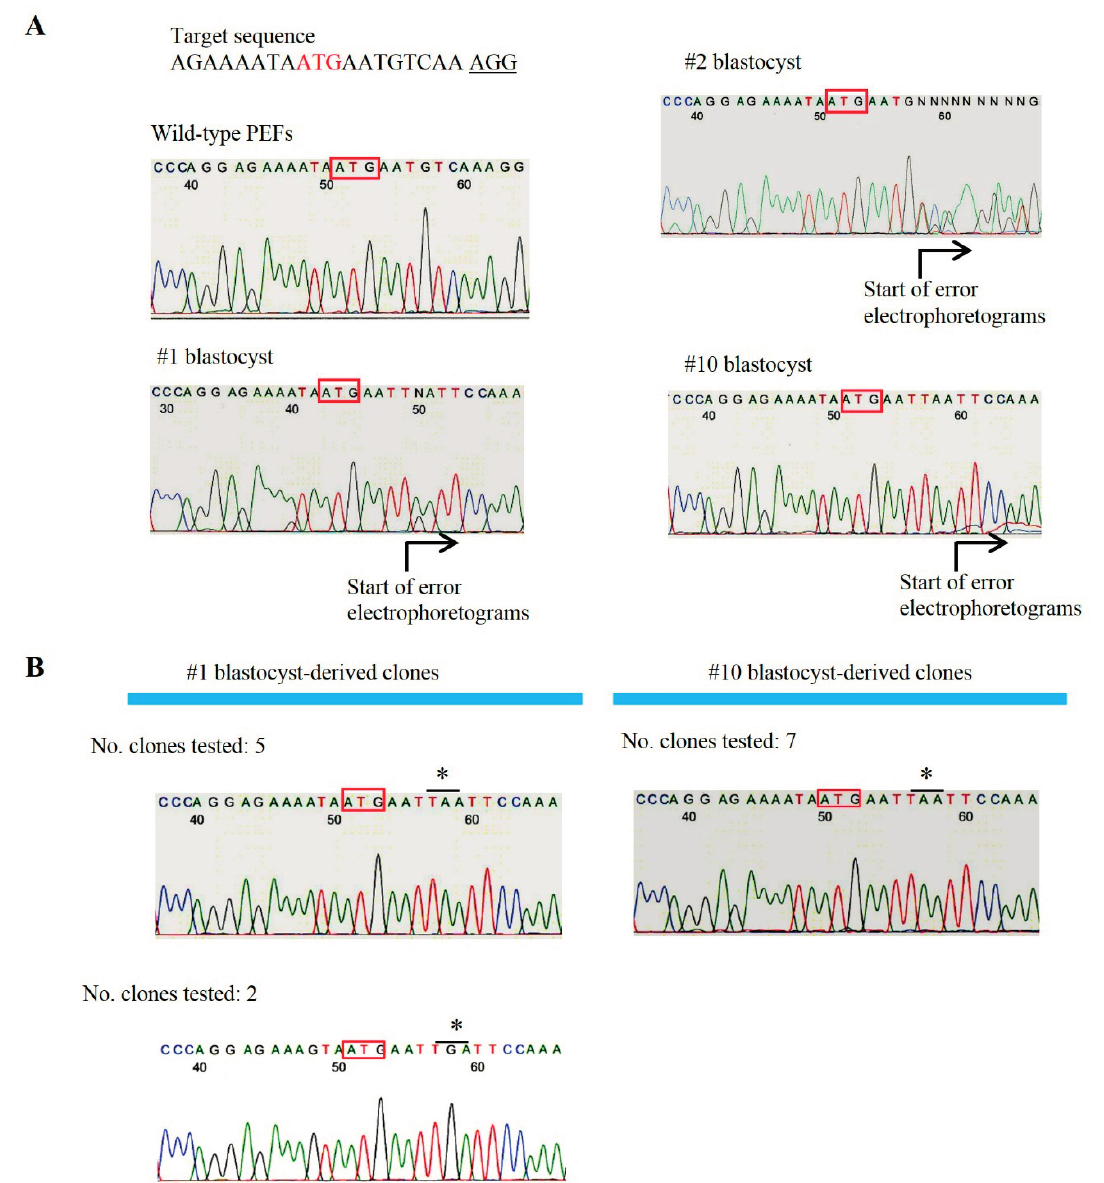
Figure 4. ( A ) Direct sequencing of PCR products (~350 bp) shown in the middle panel of Figure 3 from blastocysts No. 1, 2 and 10. Black arrows below the DNA sequence traces show overlapping peaks caused by additional indel mutations. Boxes indicate the translation initiation ATG codon; ( B ) Sequencing of the inserts derived from blastocysts no. 1 and 10 cloned into a TA cloning vector using the E-S primer set. Boxes indicate the translation initiation ATG codon. * indicate translation termination codons. In the above left corner of each DNA sequence trace, the number of clones tested is